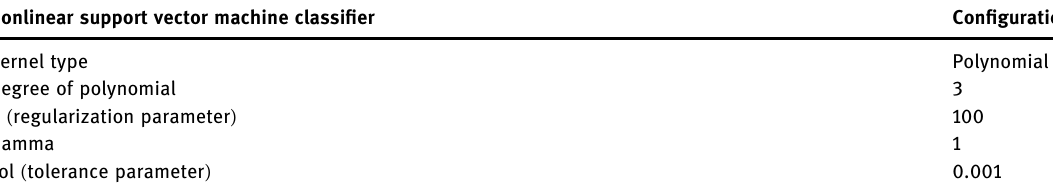
Table 2: Tuned parameters for nonlinear support vector machine classi fi